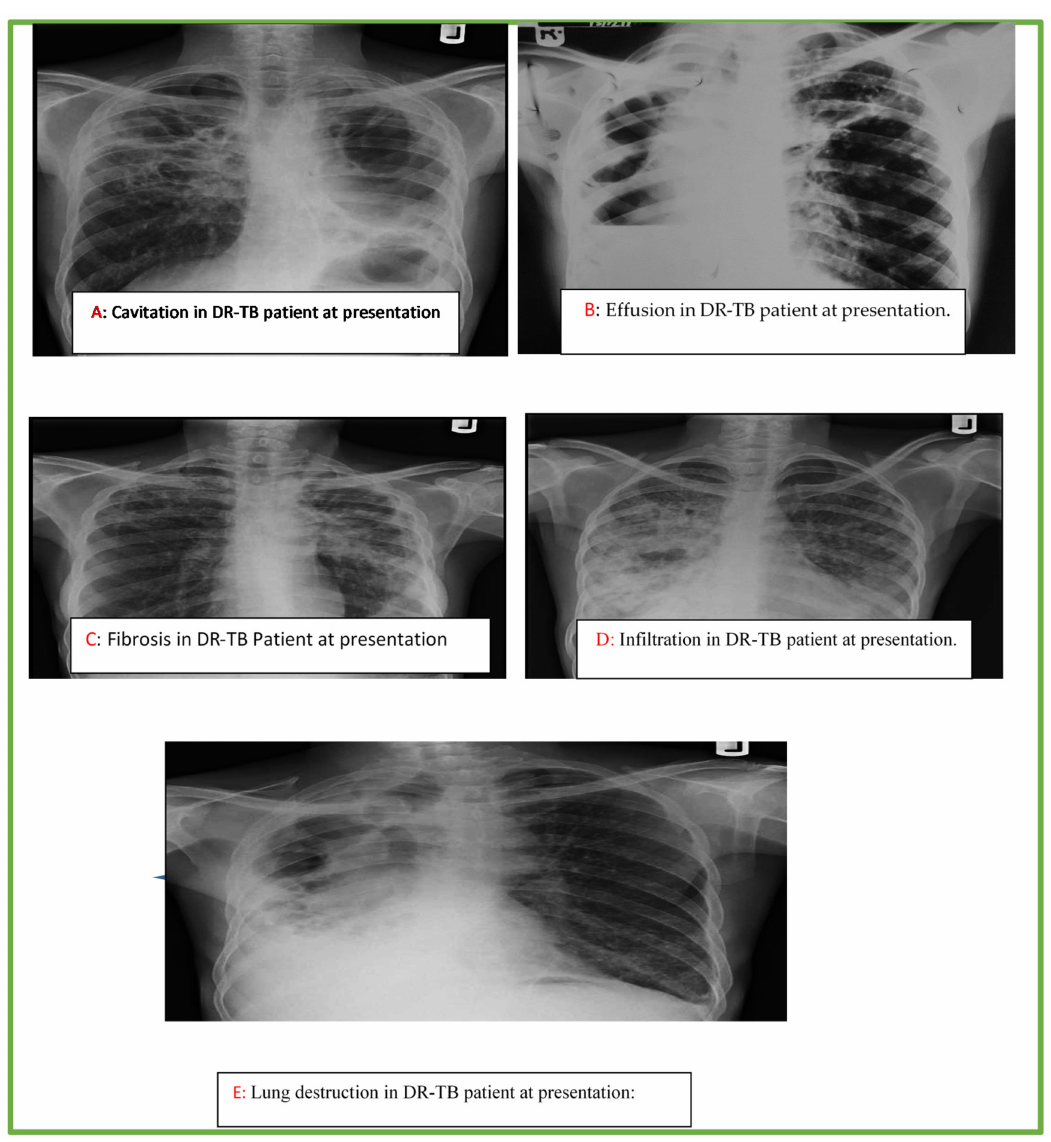
Figure 1. Cavitation ( A ), effusion ( B ), fibrosis ( C ), infiltration ( D ) lung destruction ( E ) in DR-TB patients at